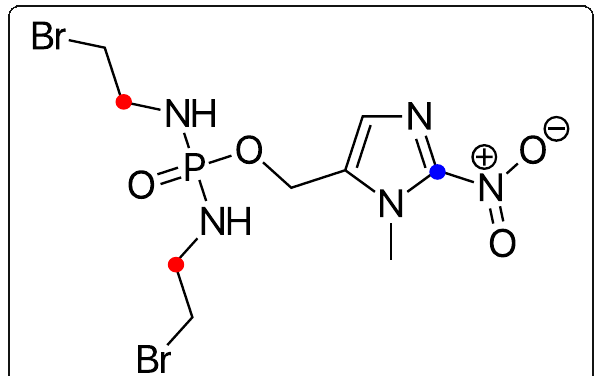
Fig. 1 Radiolabeled evofosfamide. Drug was labeled either with tritium (red) or 14 C (blue)